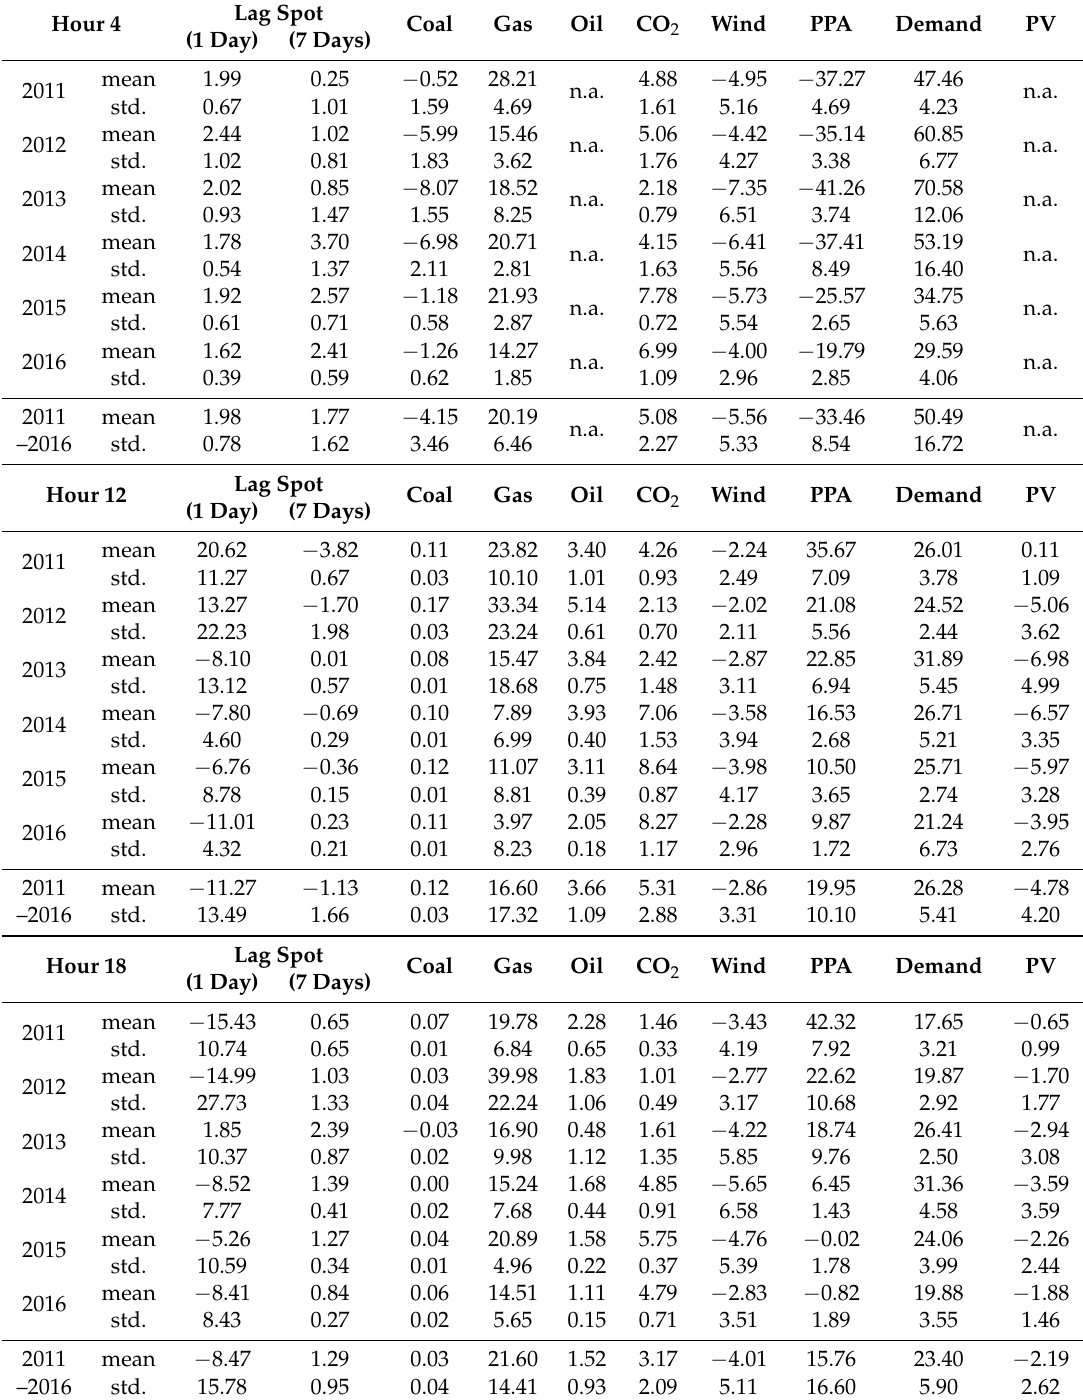
Table A1. Means and standard deviations of the marginal effects in EUR/MWh per year and for the whole sample period forworking